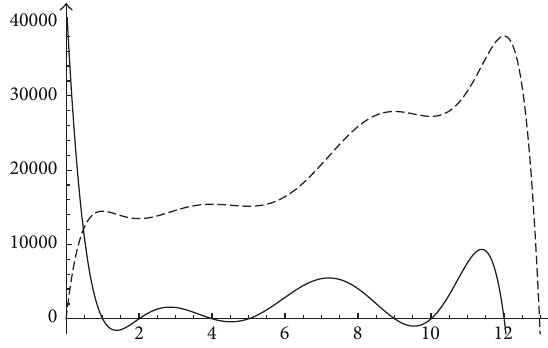
Figure 3: Graphs of the function 𝑓(𝑥) and 𝐹(𝑥) (dashed).